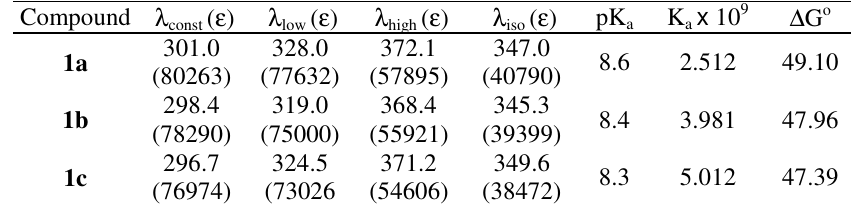
Table 3. Spectral and thermodynamic data # of